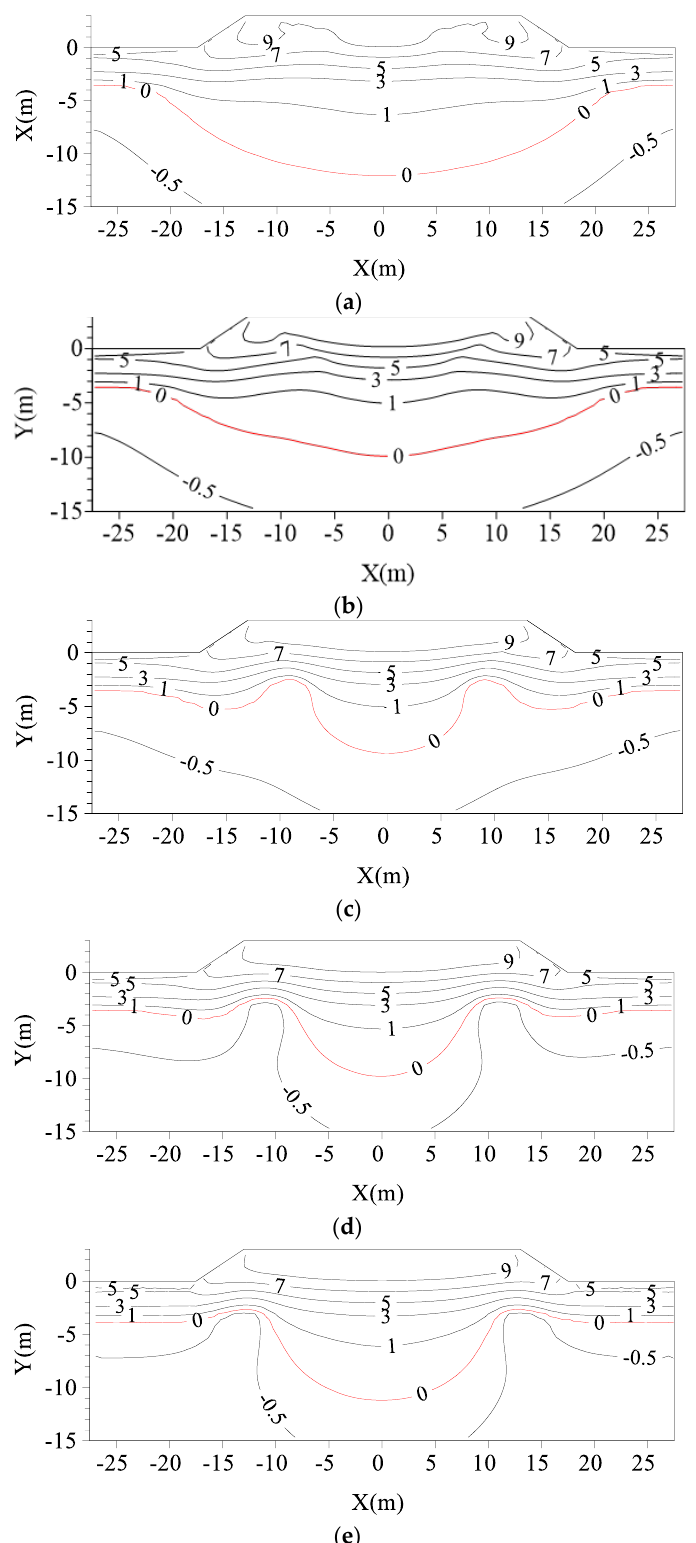
Figure 8. Geotemperature distributions of subgrades with L-shaped TPCTs under different α values on 1 October of the fifth year after their construction (unit: ◦ C): ( a ) α = 15 ◦ ; ( b ) α = 30 ◦ ; ( c ) α = 50 ◦ ; ( d ) α = 70 ◦ ; ( e ) α = 90 ◦